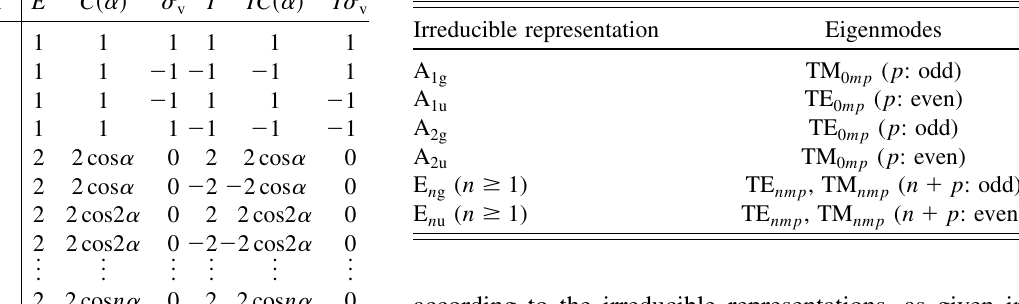
[3,4]. TABLE III. Classification of the eigenmodes in a pillbox cav- h ity according to the irreducible representations of the group D 1